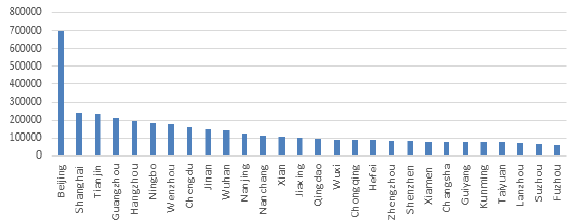
Figure 3. Zoning distribution of user access